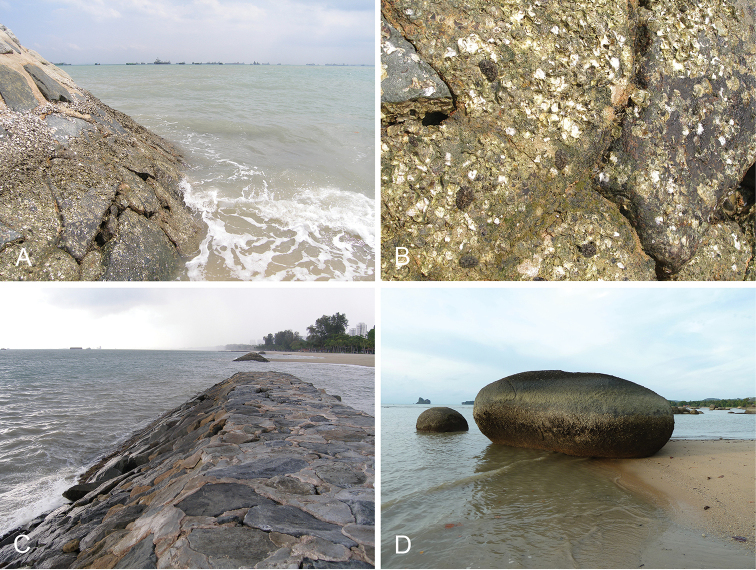
Habitats, Peronia
verruculata (unit #3) A Singapore, rocky shore covered by oyster flats (st 2) B slugs on the rocks, same as A (st 2) C Singapore, rocks of artificial breakwaters (st 3) D Peninsular Malaysia, Langkawi, large boulders on sand beach (st 25).